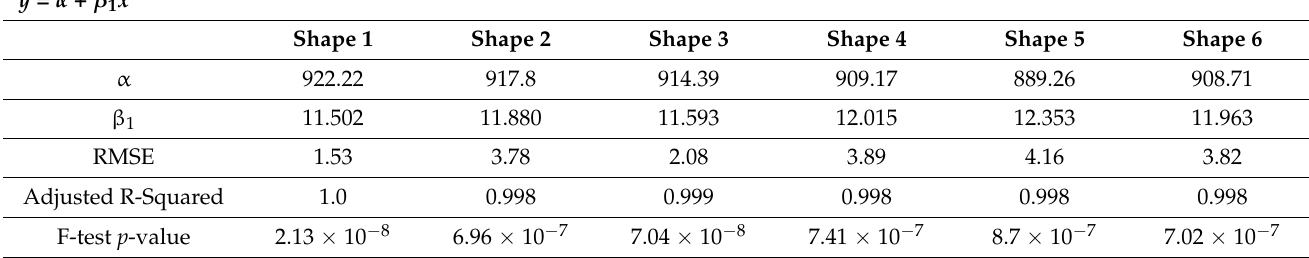
Table 12. Fitted lines of plug load